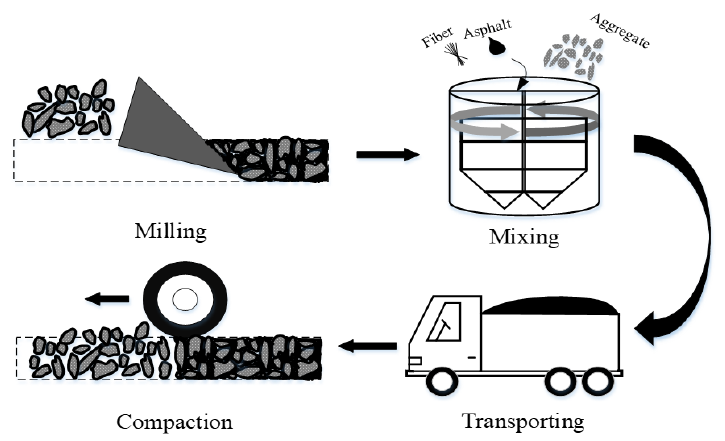
Figure 2. Milling resurfacing process.